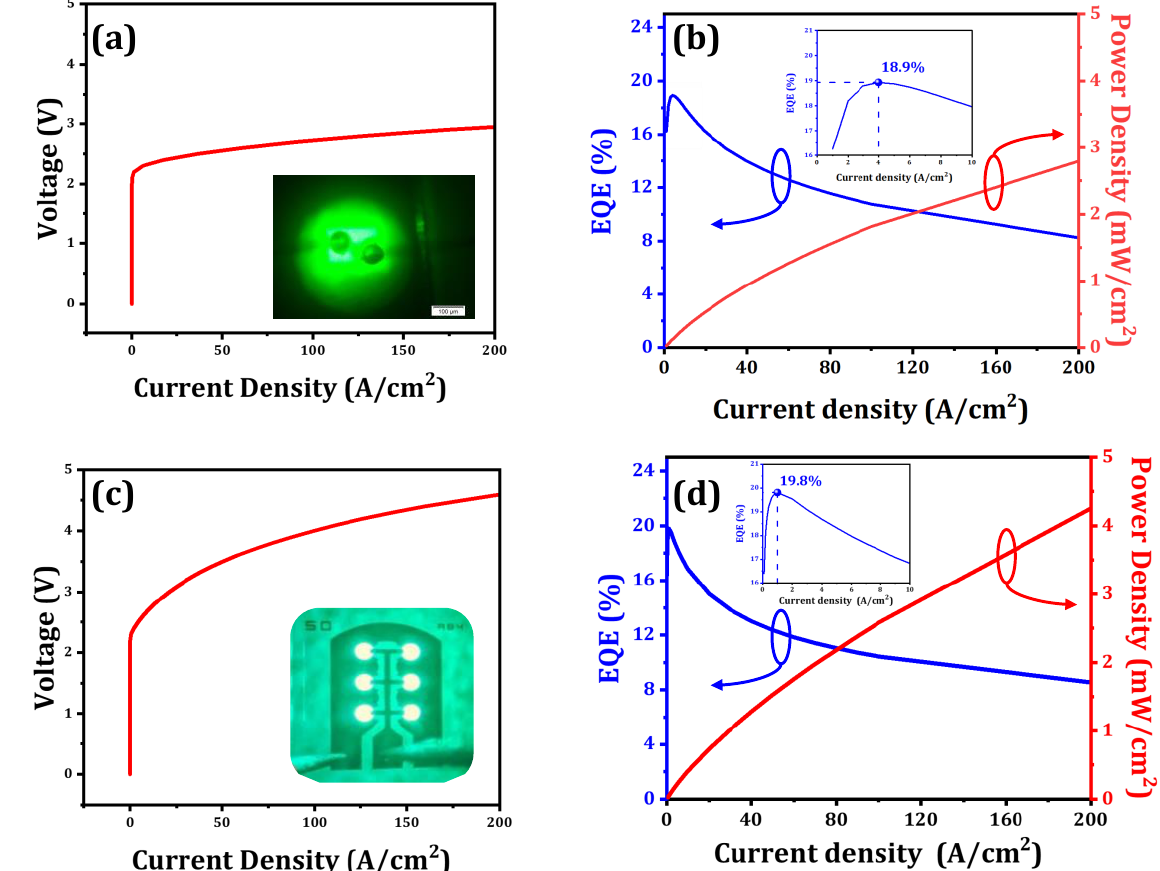
Figure 1. Measured ( a ) voltage and ( b ) external quantum efficiency and power density of the commercial green μ-LEDs with regular quantum wells as a function of current density, the inset is the optical microscopic view of the commercial μ-LED, where the scale is 100 μm. Measured ( c ) voltage and ( d ) external quantum efficiency and power density of μ-LEDs with staggered quantum wells as a function of current density, the inset is the optical microscopic view of the μ-LED in this work.